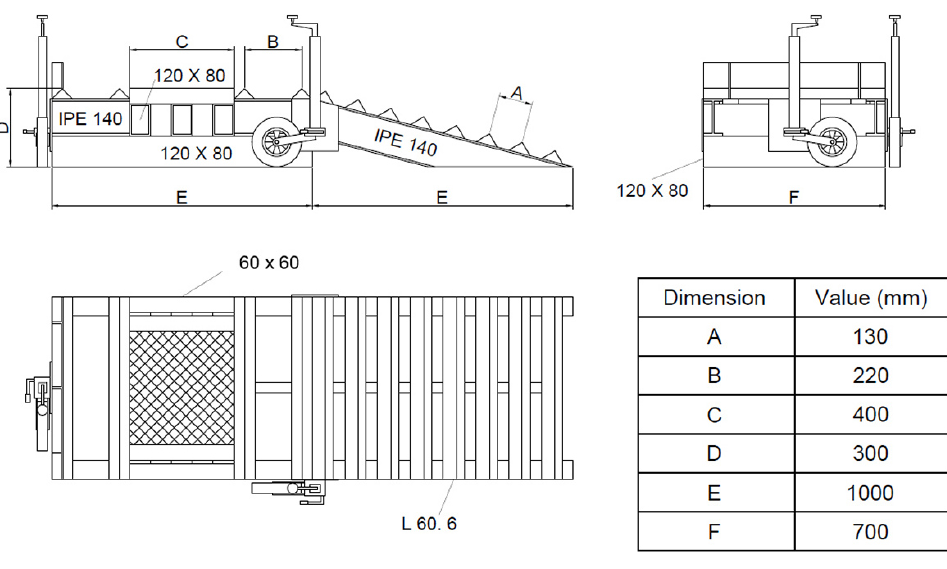
Fig. 1. Final design of the